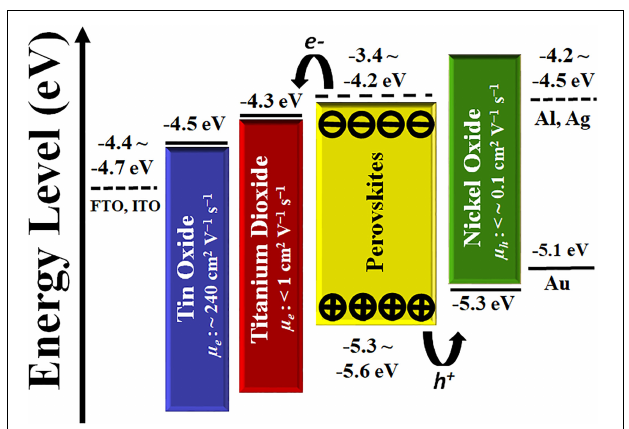
FIGURE 2 | Schematic illustrations of the energy bandgap of metal oxide charge transport materials and their carrier mobility (Jiang et al., 2018; Napari et al., 2020) in the bulk